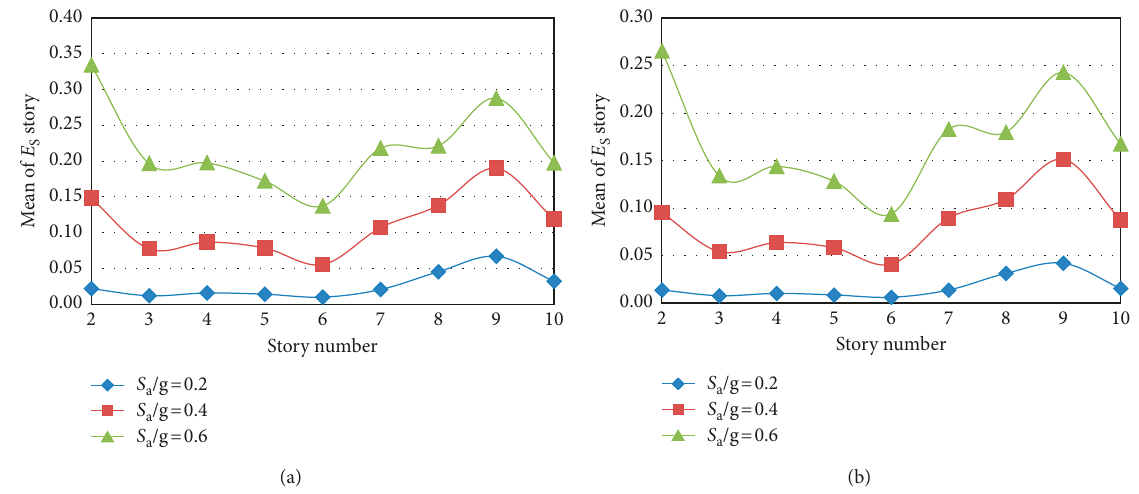
Figure 8: Mean values of story normalized energy demands, 10-level building: (a) NS direction; (b) EW